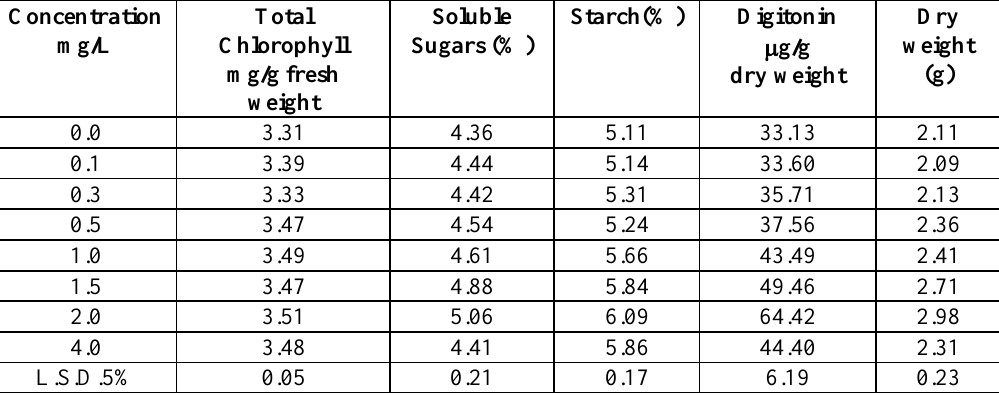
Table 1 : Effect of different concentrations of Cholesterol. with the presence of 0.5 mg/L TDZ on the content of multiplied shoots of Digitalis purpurea from the total chlorophyll , soluble sugars , starch , digitonin and on their dry weight.